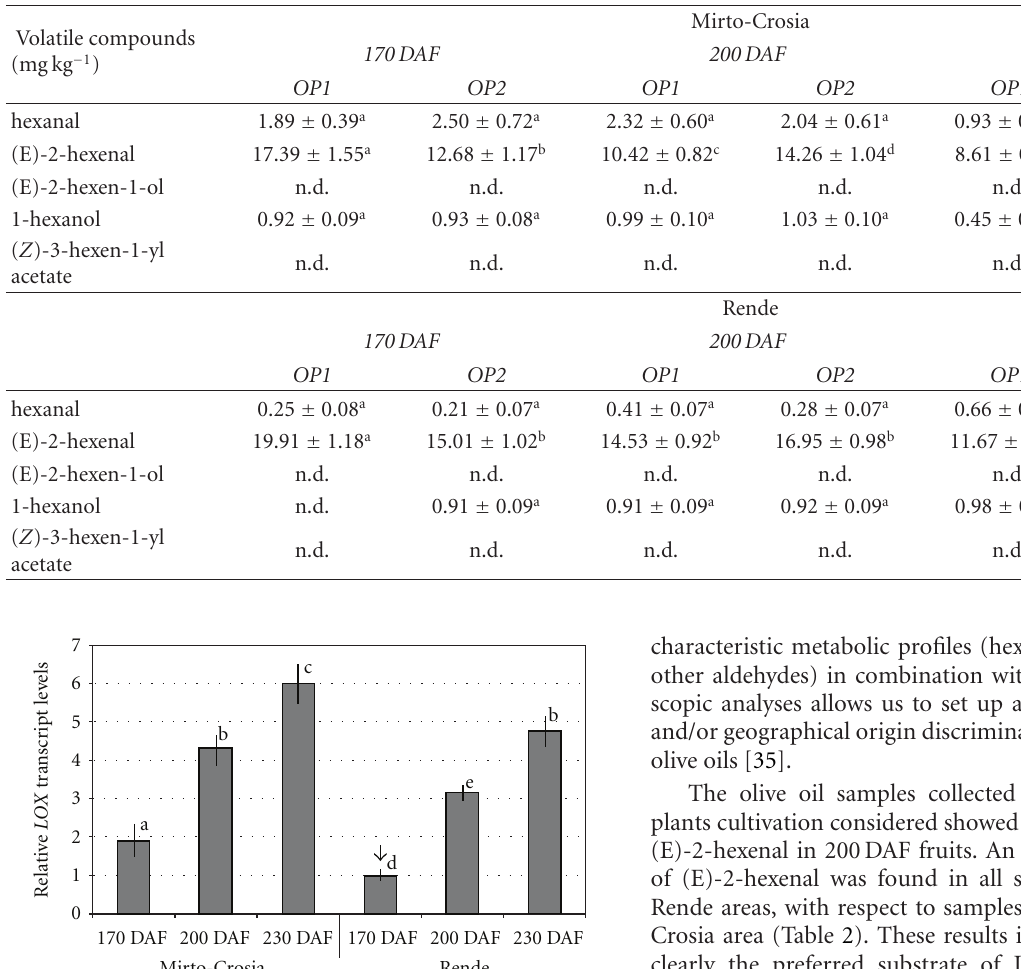
Table 1: Content of five volatile biomarkers: (2-(E)-hexenal, hexanal, 1-hexanol, (E)-2-hexen-1-ol, and ( Z )-3-hexen-1-yl acetate) analyzed in the olive pastes obtained from “Coratina” cv. Samples were performed with and without malaxation ( OP1 , t = 0min; OP2 , t = 30min). The drupes were collected at three developmental stage of ripening (170 days after flowering DAF = green mature; 200 DAF = black with < 50% purple flesh; 230 DAF = black with > 50% purple flesh) and in two di ff erent cultivation areas (Rende and Mirto-Crosia). Data on volatile biomarkers contents from olive paste are expressed in mg/kg. Data are expressed as mean values ± standard deviation of three independent experiments. Duncan test has been used to assess significance ( P = 0 . 05). Values followed by di ff erent letters in the same line are significantly di ff erent. n.d.: not detected.